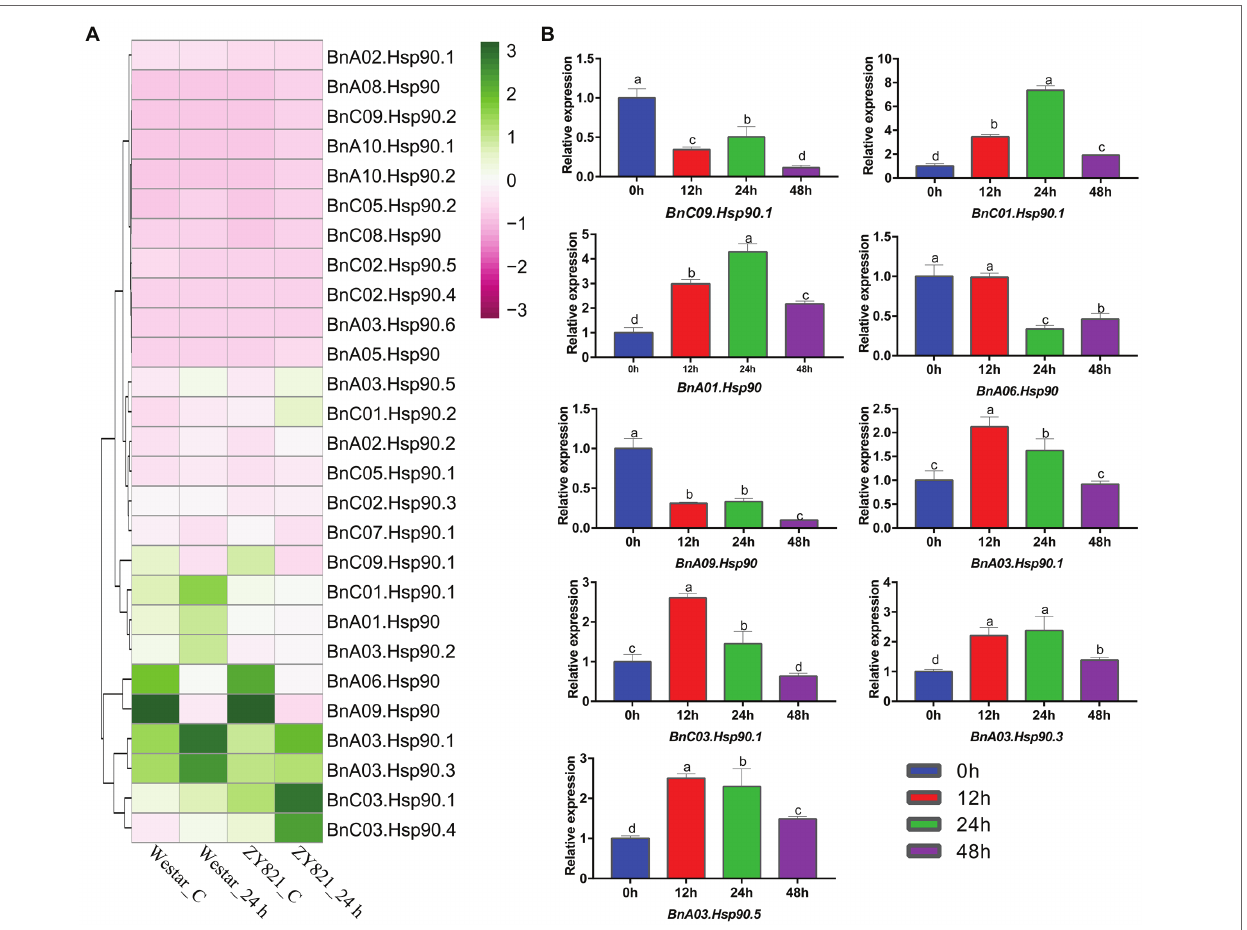
FIGURE 6 | Expression of BnHsp90 genes in Brassica napus infected by Sclerotinia slcerotiorum . (A) Expression changes of BnHsp90 genes after Sclerotinia sclerotiorum infection from public dataset (GEO RNA-seq datasets, GSE81545). The materials used are Westar and ZY821. The treatments are divided into 0 h and 24 h post inoculation. (B) Expression patterns of BnHsp90s in response to Sclerotinia sclerotiorum . Transcript levels of BnHsp90s were analyzed by quantitative real-time PCR using actin gene as an internal control. The non-inoculated expression level (0 h) was regarded as a standard. Values are the mean ± SE, n =